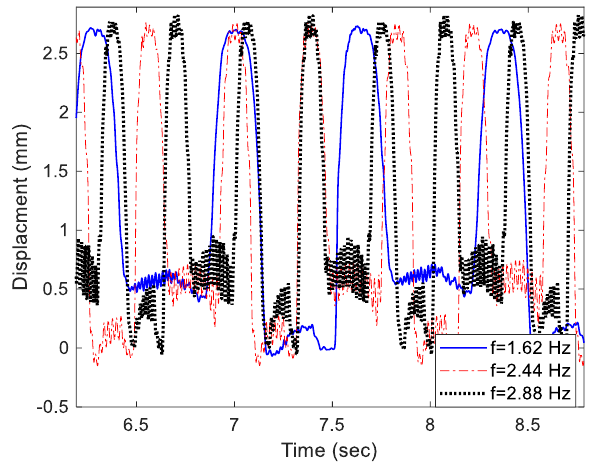
Figure 5. Tip deflection measurement of CTLPH at various slider frequencies.